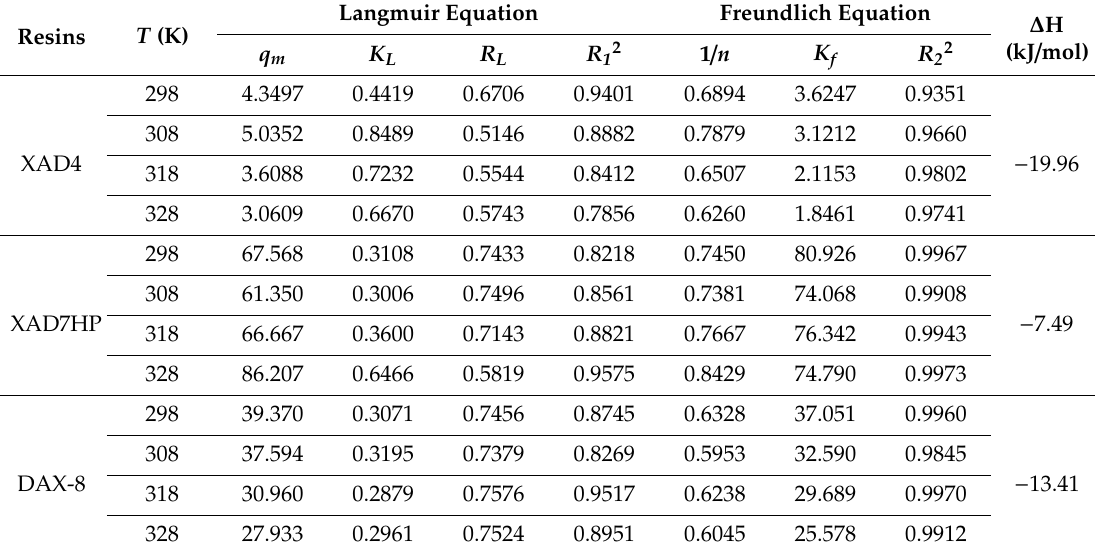
Table 2. Langmuir model, Freundlich model, and thermodynamic parameters of OPL total flavonoids on the XAD4, XAD7HP, and DAX-8 resins.